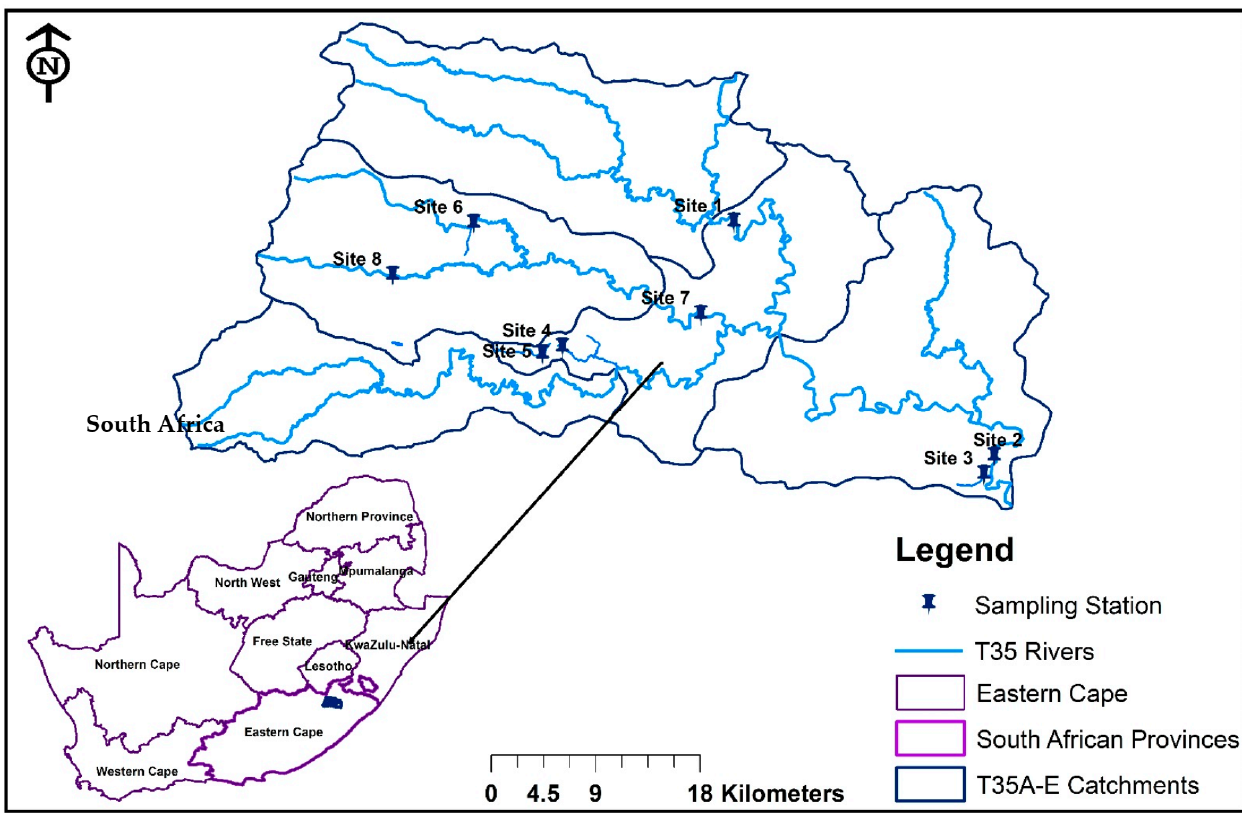
Figure 1. Map of the study area showing the locations of the eight selected sampling sites in the Tsitsa River and its tributaries. The study area location in South Africa is shaded in dark blue in the Eastern Cape Province on the map of South